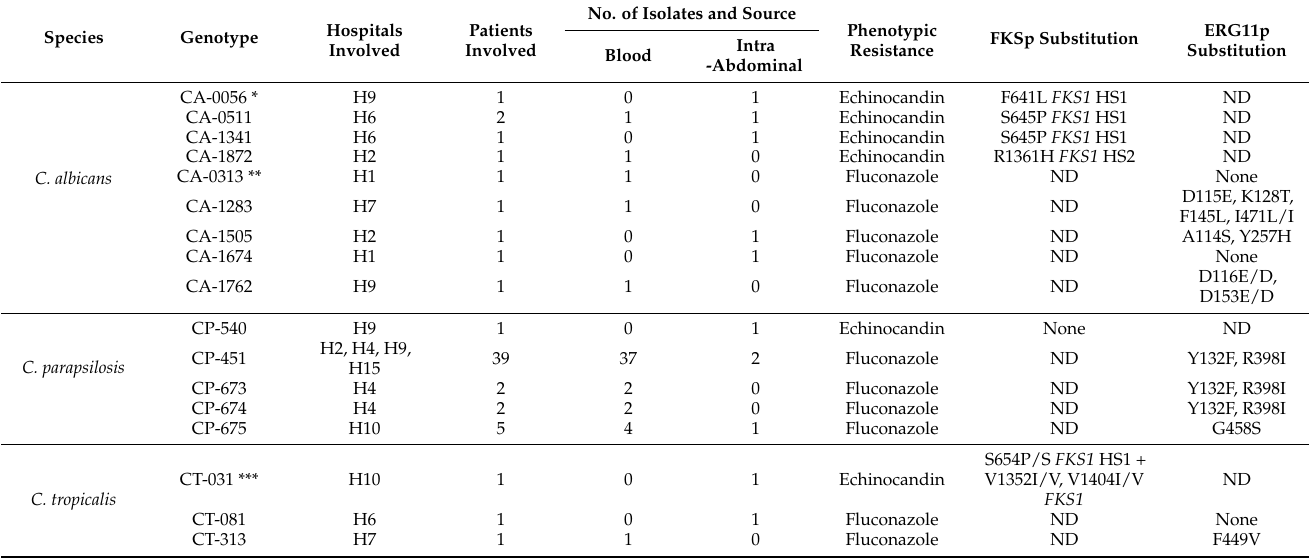
Table 5. Resistant genotypes found in blood cultures and intra-abdominal samples, hospitals, patients involved, and molecular resistance